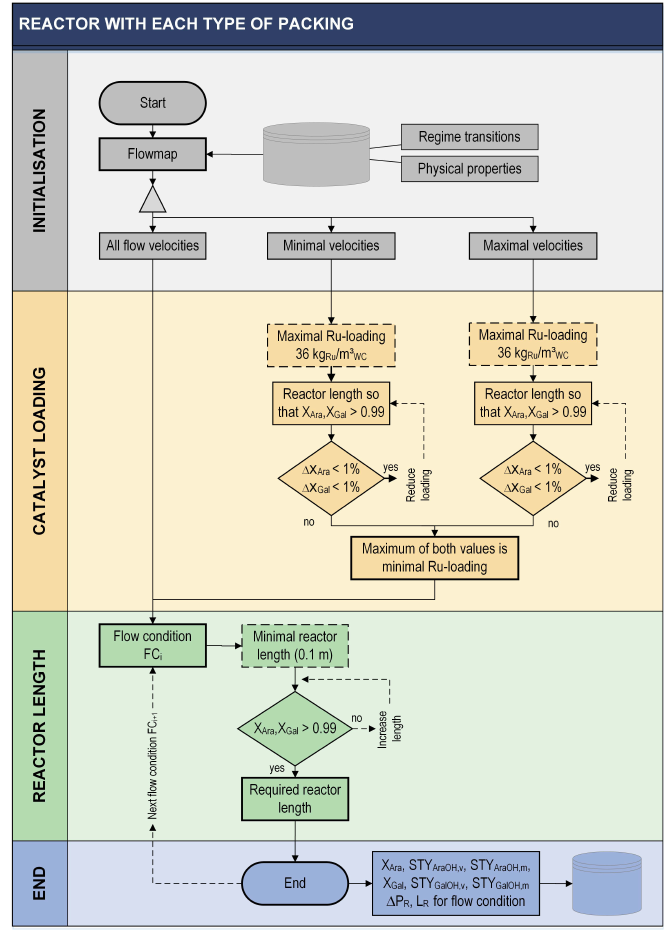
Figure 4. Principles of optimisation studies for each reactor